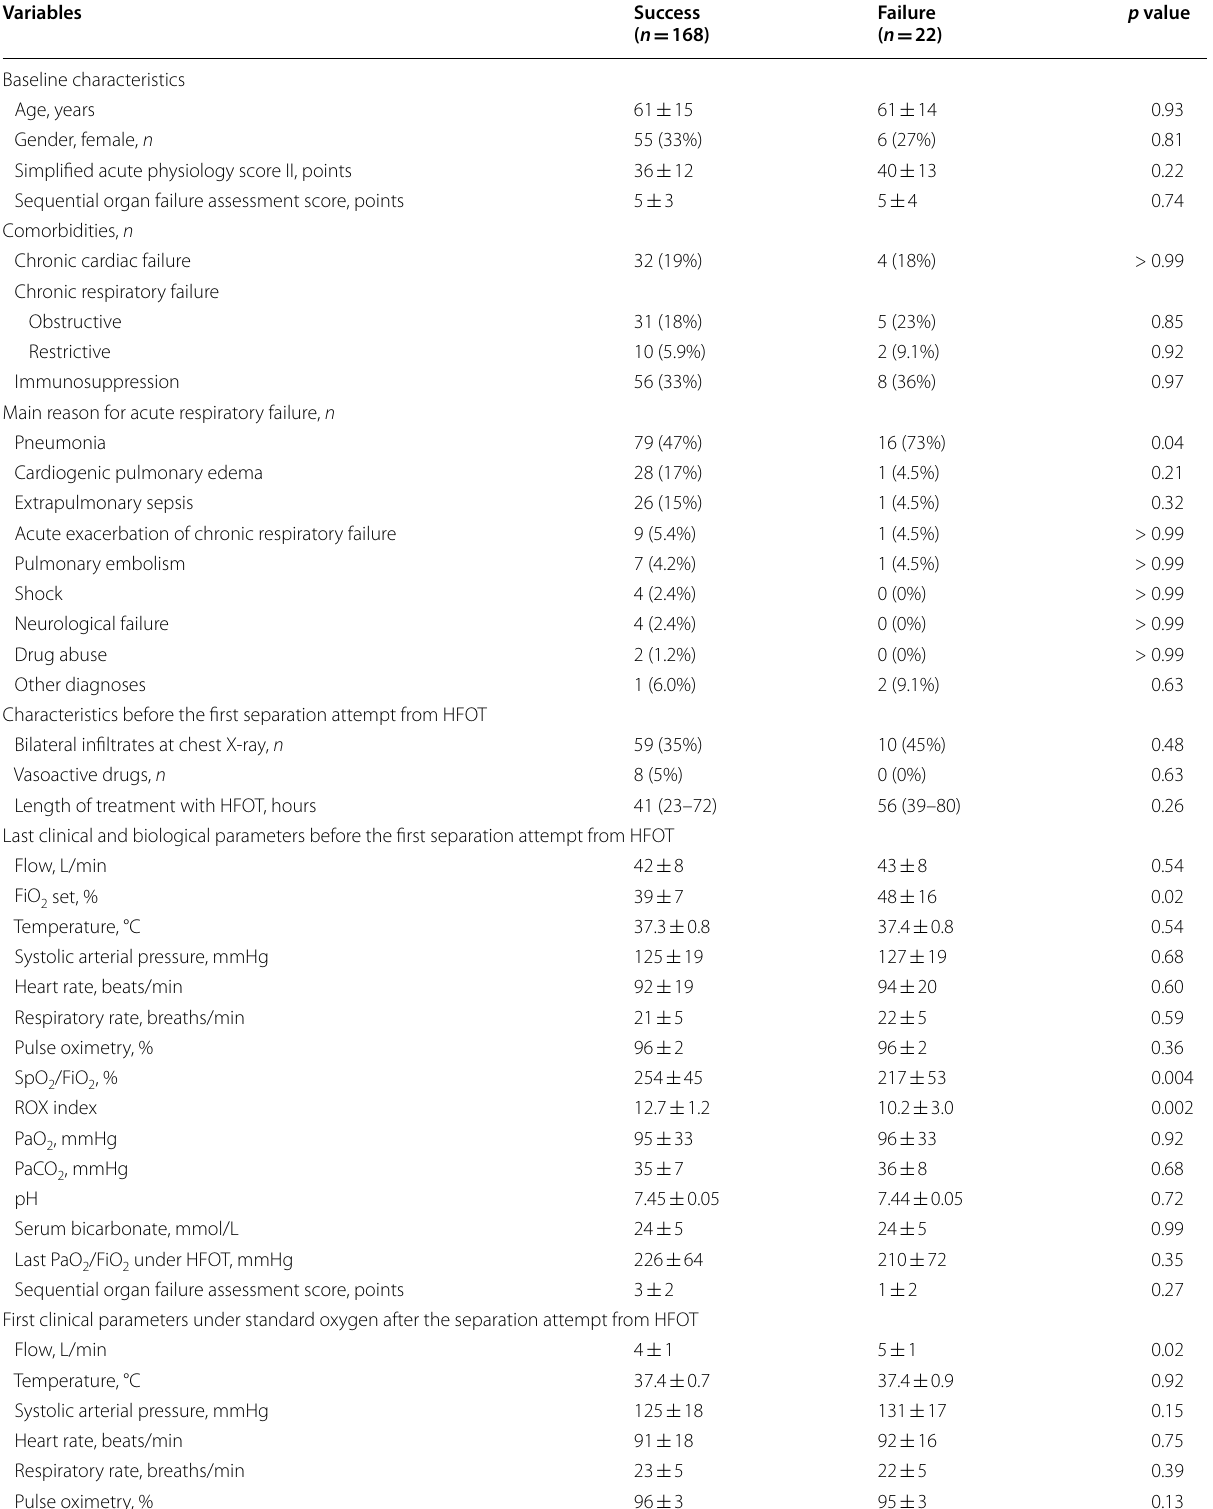
Table 2 Characteristics of patients according to the success or failure of the first separation attempt from high-flow nasal oxygen